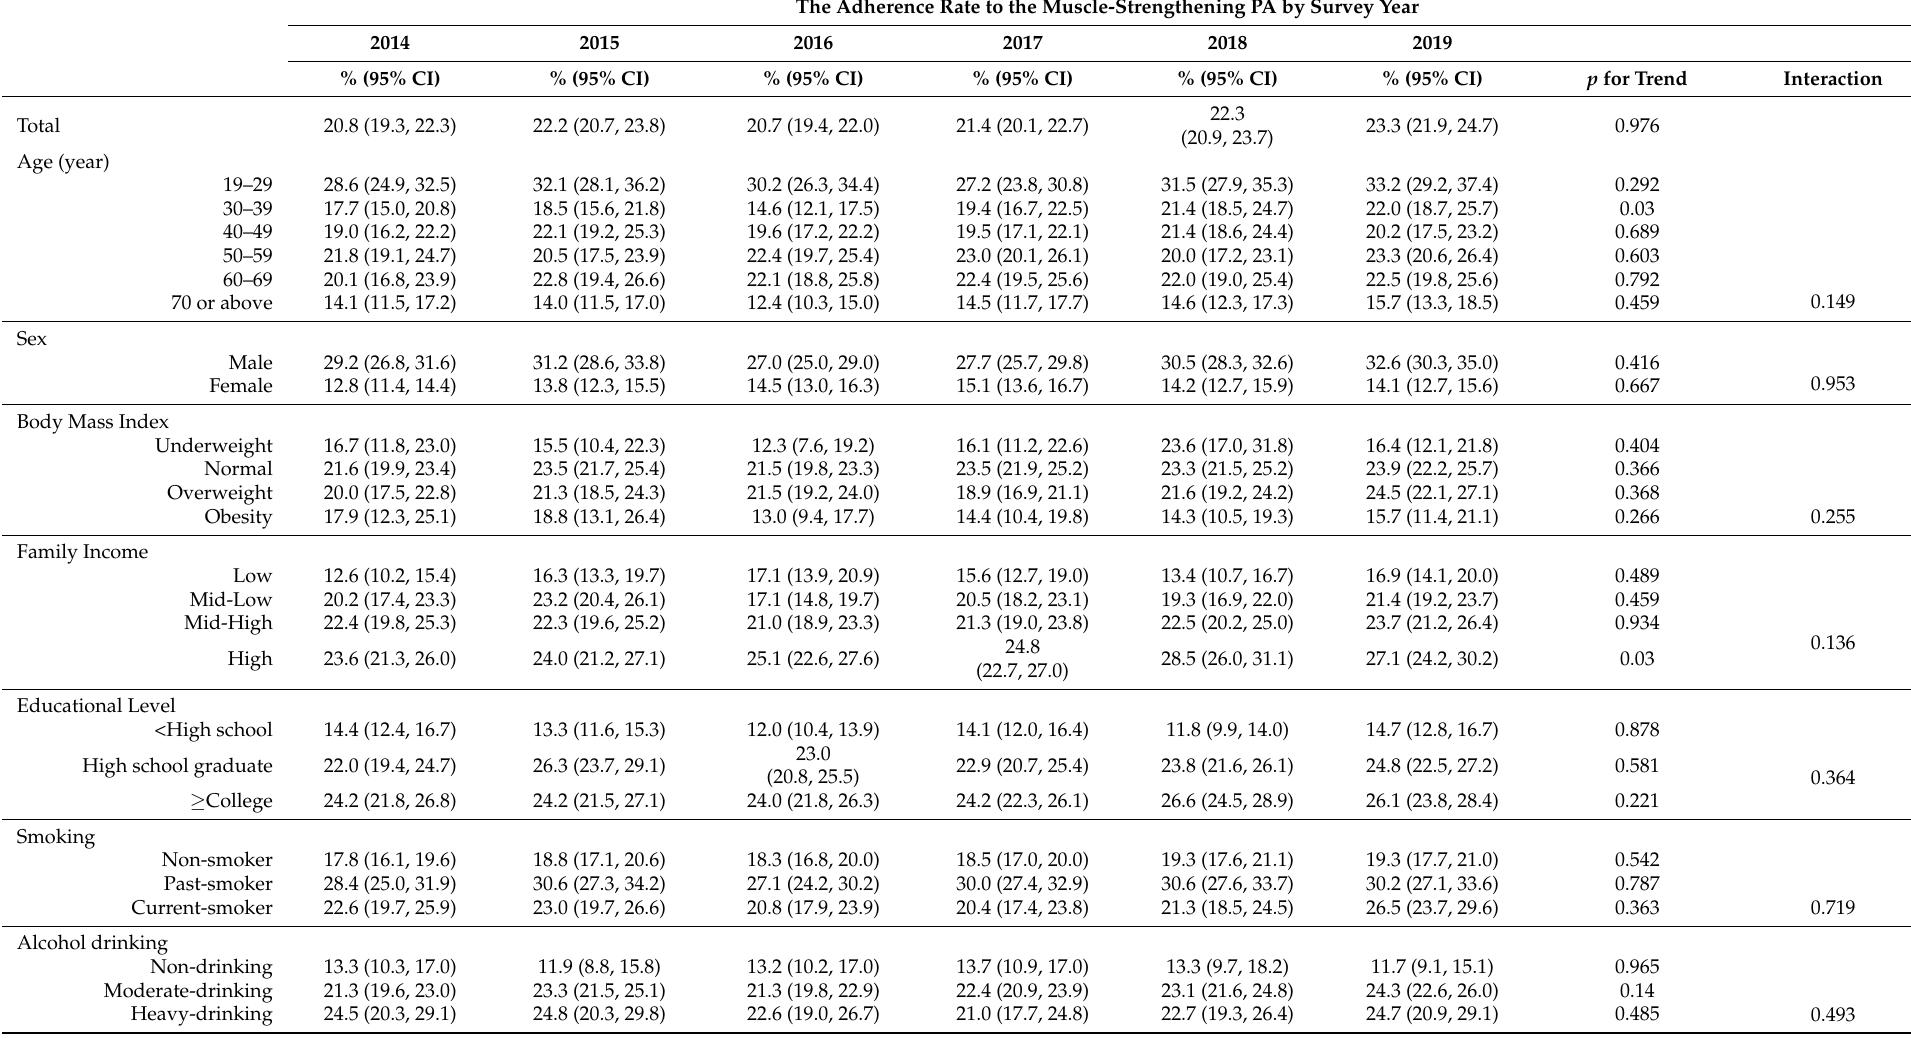
Table 3. Changes in adherence rate to the muscle-strengthening PA guideline by survey year. The Adherence Rate to the Muscle-Strengthening PA by Survey